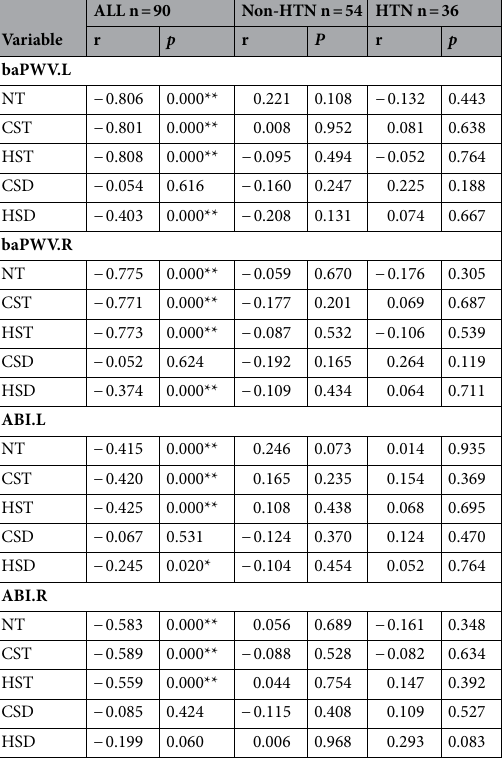
Table 2. Correlation analysis between microvessel area and arterial stiffness in normal population and hypertensive